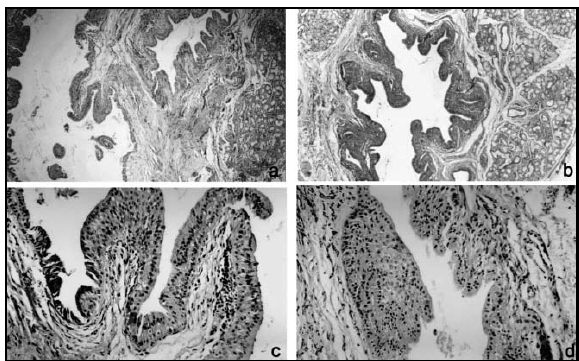
Figure 1 – A: Microcysts and well differentiated mucous acini (H&Ex40); B: cystic cavity exhibiting papillary projections supported by fibrous connective tissue (H&E x100); C: papillary projection lined by tall columnar cells (H&E x400); D: papillae showing oncocytic metaplasia (H&E